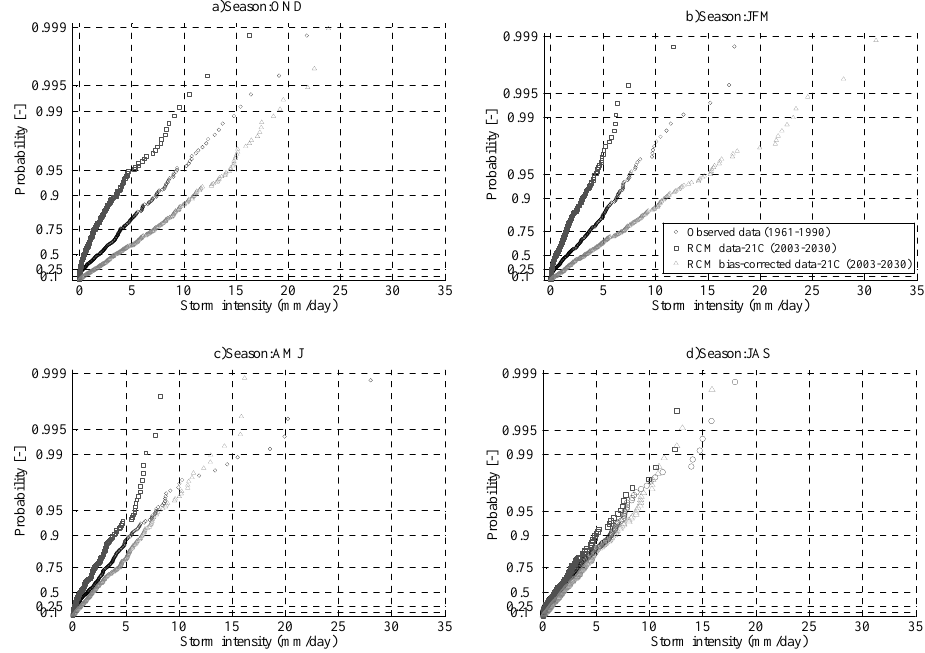
Fig. 12. Comparison for one RCM grid-cell (cell #4) between the probability plots of storm intensities obtained from the reference obser- vations (circles), the RCM output for the 21st century (squares) and the bias-corrected rainfall (triangles). Storm intensities are reported for autumn (a) , winter (b) , spring (c) and summer (d)